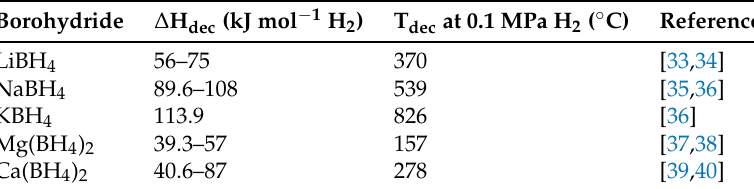
Table 1. Key thermodynamic properties for common M(BH 4 ) n (M = Li, Na, K, Mg, Ca) compounds [32]. Enthalpy of decomposition ( ∆ H dec ) values are given as ranges to reflect differing results from the variety of experimental and theoretical methods that have been utilised to specify this parameter. Because of the impact of hydrogen back-pressure on the temperature at which hydrogen release begins, the decomposition temperature (T dec ) is reported for a hydrogen equilibrium pressure of P = 0.1 MPa to allow for easy comparison between different